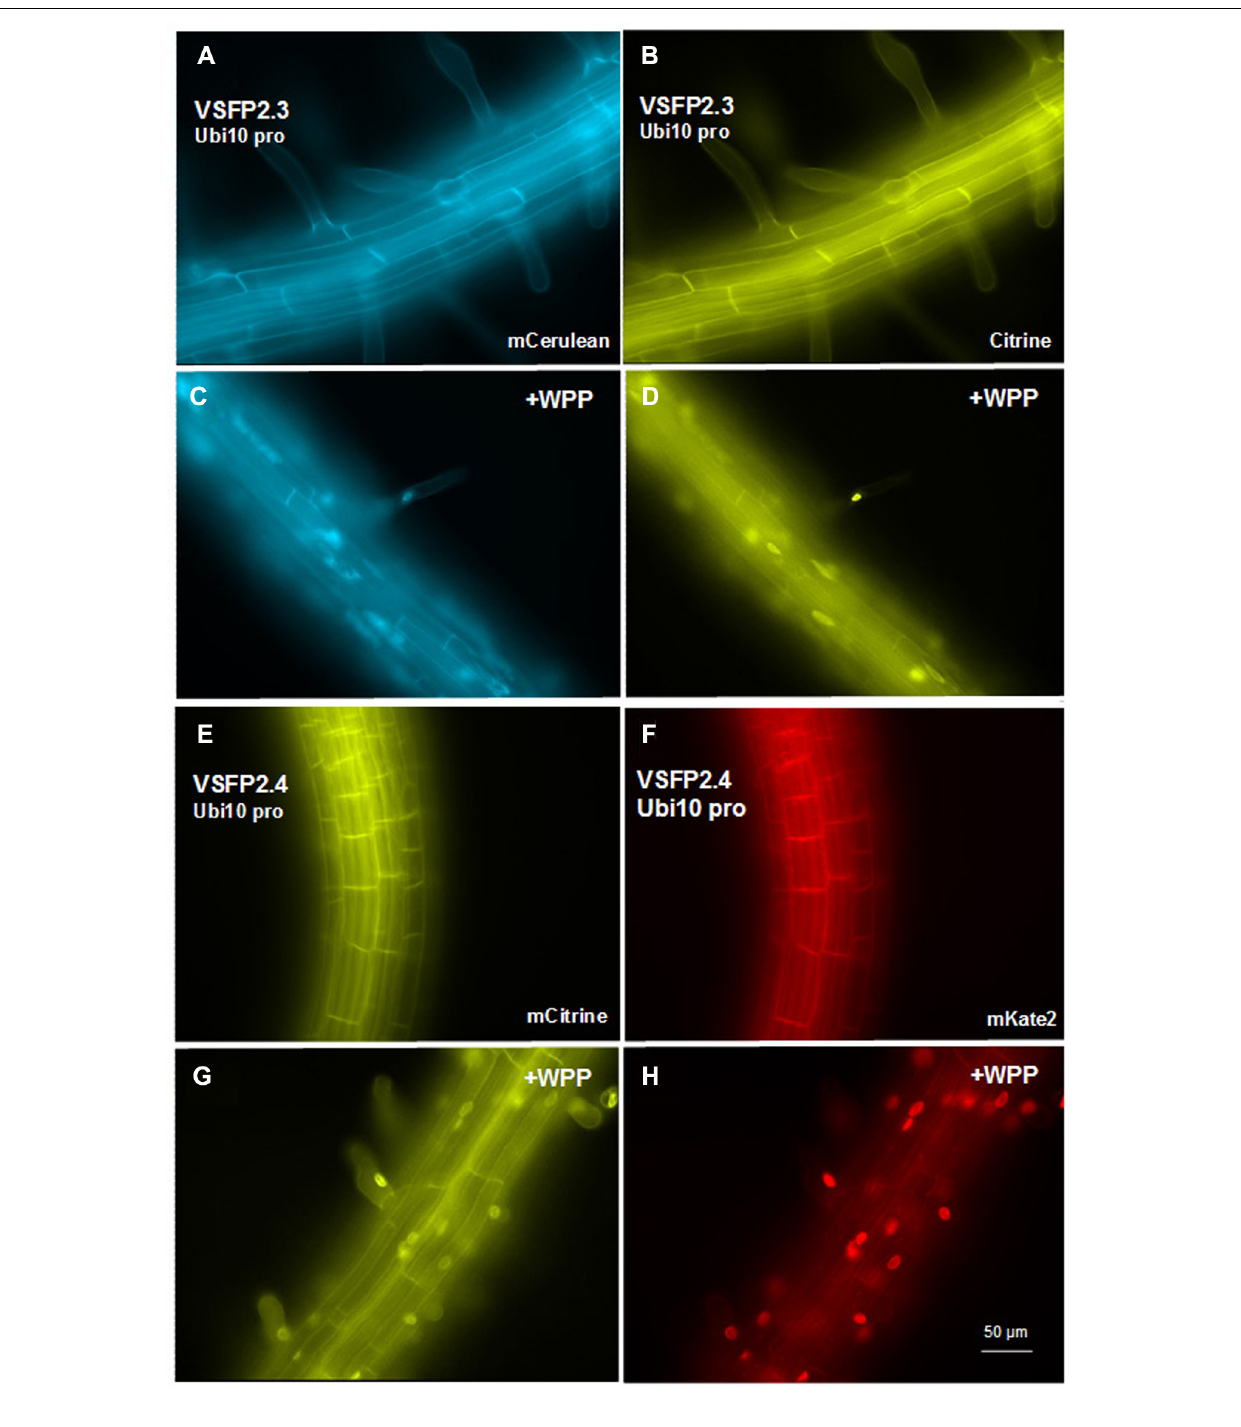
pair mCitrine and mKate2; E,F , plasma membrane; G,H , + WPP, nuclear membrane).The weaker plasma membrane fluorescence than nuclear fluorescence in (G) and (H) indicates that ONM targeting of the ubiquitin-10 promoter-drivenVSFP2.4 is more specific than the RPS5 promoter-driven VSFP2.4 ( Figure 7 ). Images shown are fluorescence wide field images acquired after focusing on the top cell layers of the root or the root hair. Each image was made using the respective excitation and emission wavelengths of the individual chromophores (see Figure 3